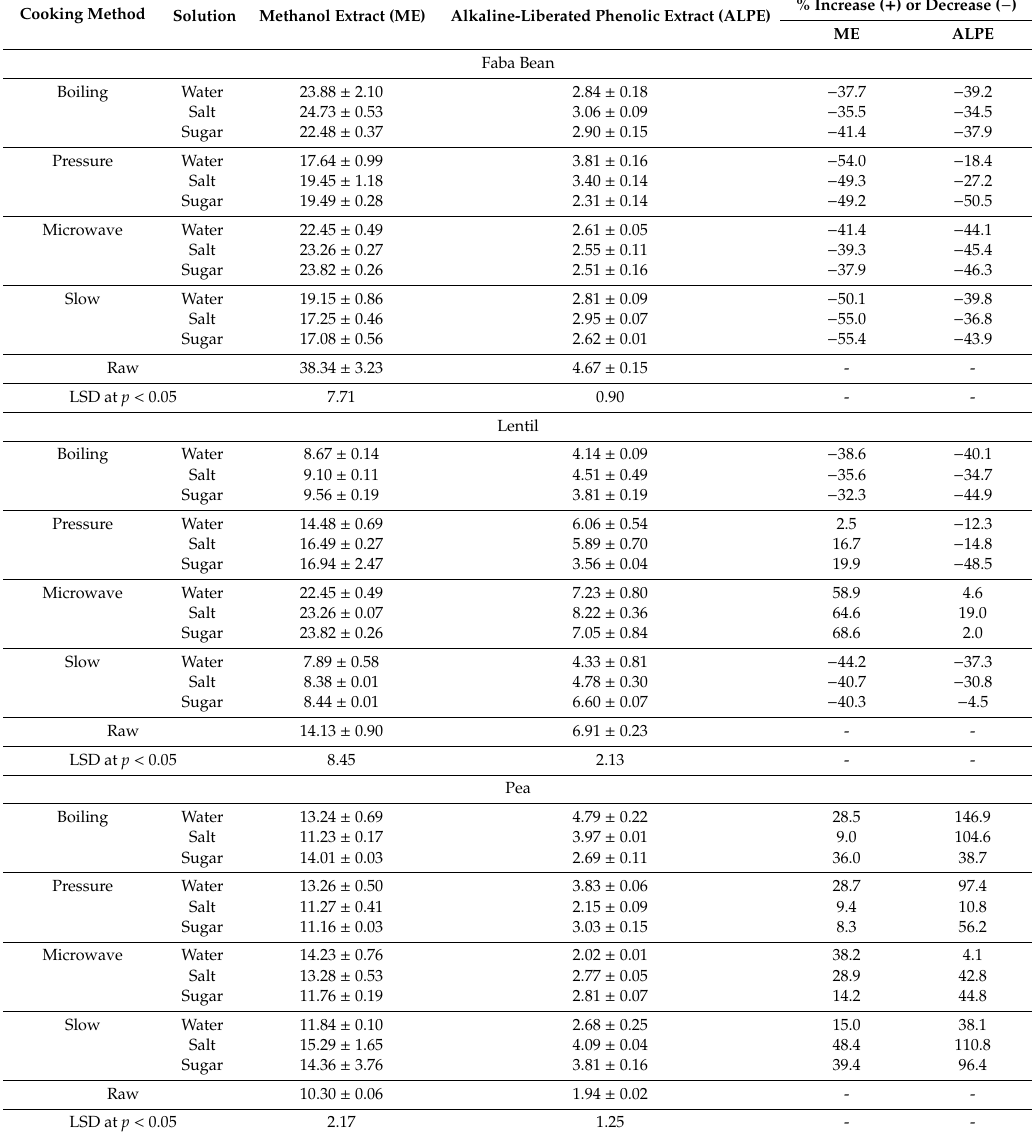
Table 4. E ff ect of four cooking methods on the total phenol content of methanol and alkaline-liberated phenolic extracts from pulses (mg ferulic acid equivalents / g,